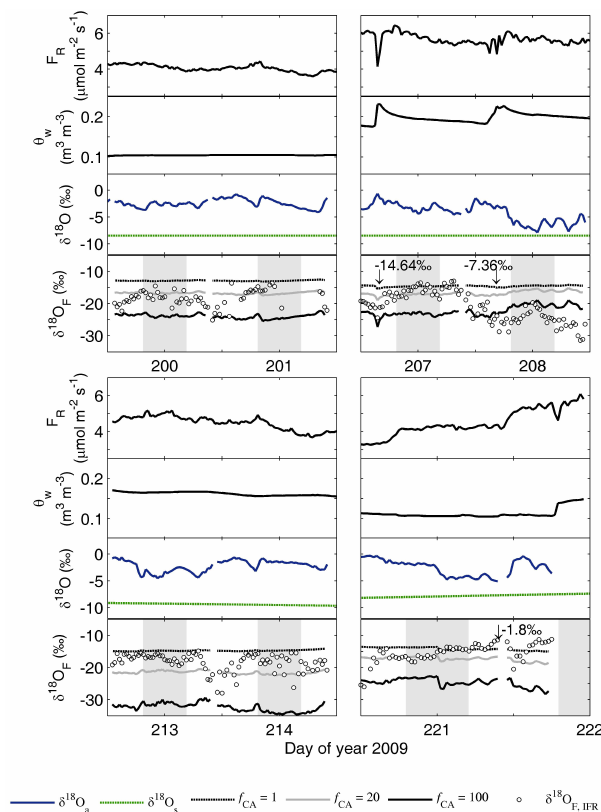
Fig. 8. Half-hour values of soil CO 2 flux ( F R ) , soil water content ( θ w ) and C 18 OO composition of the air ( δ 18 Oa, blue solid line), ex- pressed using the VPDB scale, during four selected periods. H 18 composition of the soil water ( δ 18 Os, VSMOW scale) at the 10cm depth between two sampling dates. C 18 OO composition of CO 2 flux ( δ 18 O F ) near the forest floor obtained using the isotope flux ra- tio method ( δ 18 O F , IFR , open circles) and modeled δ 18 O of net soil CO 2 flux (lines) according to Wingate et al. (2009) using three val- ues for the relative increase in hydration due to the enzyme carbonic anhydrase activity in the soil ( f CA , Eq. 7) in a temperate decidu- ous forest. The δ 18 O of CO 2 flux is expressed in the VPDB scale. Shaded areas in the graph indicate nighttime periods, and arrows indicate precipitation events with respective isotope composition of precipitation water expressed in the VSMOW